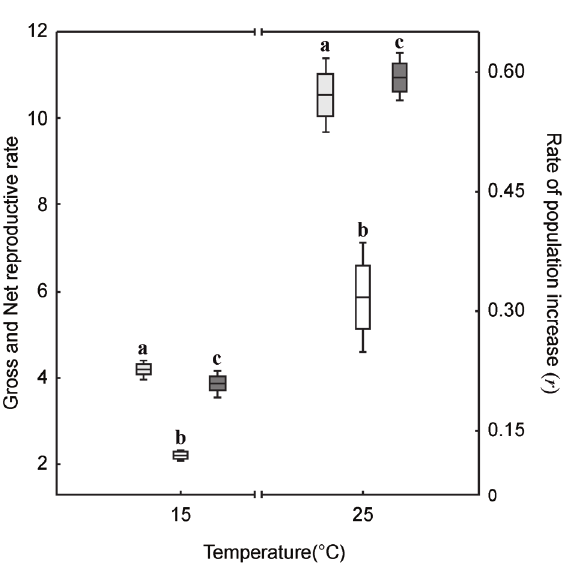
Figure 5 - Box plots of gross ( a ) and net ( b ) reproductive rate, and rate of population increase ( c ) of Brachionus plicatilis at 15 and 25 ºC. Figure indications relative to the median value: box, 25%-75%; whiskers, maximum and minimum values within 95% of the distribution; and points,